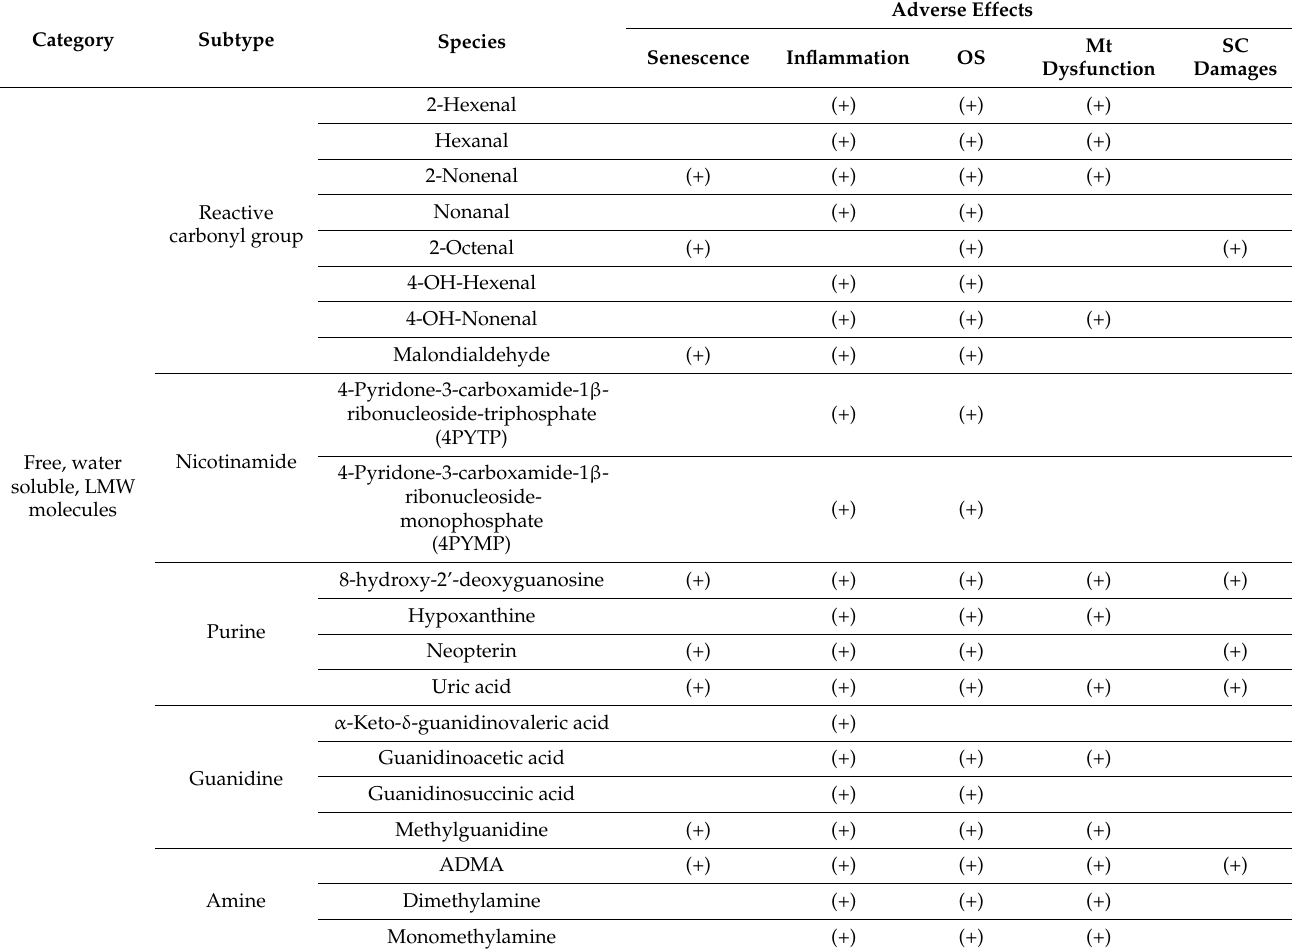
Table 1. Classification and potential adverse effects of uremic